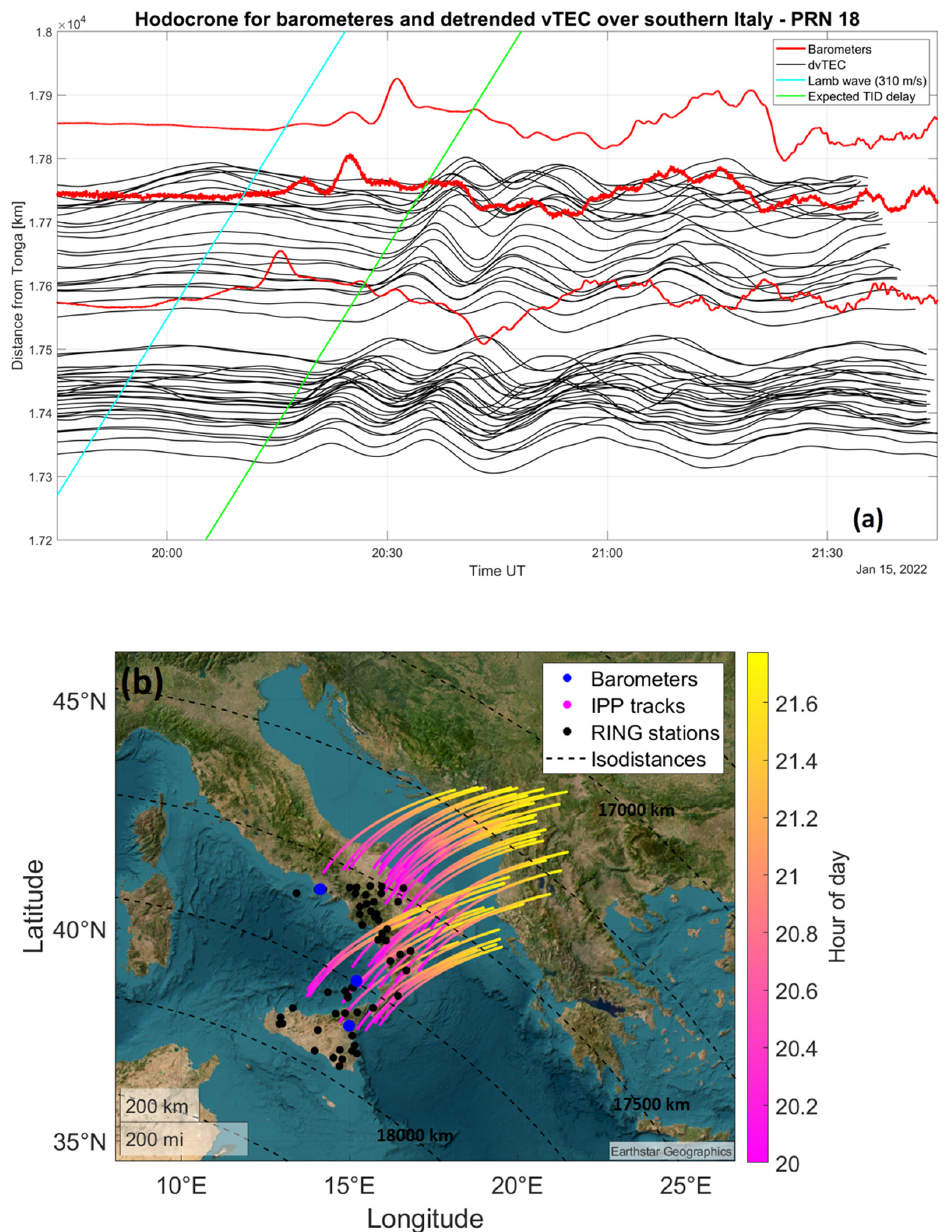
Figure 9. ( a ) dvTEC (solid black curves) as measured by RING GNSS stations from about 19:30 UT to 22 UT on 15 January 2022. The pressure variations (red curves) as registered by the barometers (red dots in Figure 2) described in the methods highlight the arrival of the neutral Lamb wave (cyan solid line), which propagates at 310 m/s, as found in Section 3.1. Respectively, from lower to higher distances from Hunga, the three barometers are located at Campi Flegrei, Stromboli and Etna. Moreover, one might notice how the signal gathered at Stromboli island shows a higher level of noise (making its red line appear thicker). The solid green line instead represents the expected TID arrival, which corresponds to 24 min after the neutral wave appearance. ( b ) Ionospheric pierce point (IPP) tracks from the different RING stations, in which colours represent the hour of the day. Dashed black curves represent the points with the same distance from the Hunga volcano. Black and blue dots represent, respectively, the location of GNSS receivers and